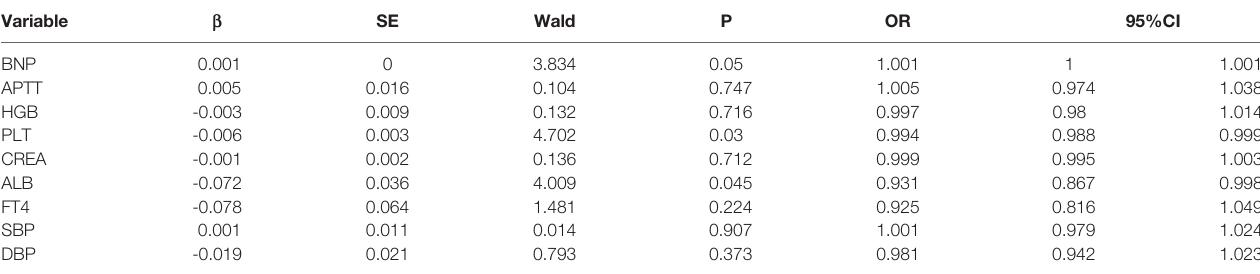
TABLE 3 | Multivariate Logistic regression analysis of ESS in fl uencing factors. Variable b SE Wald P